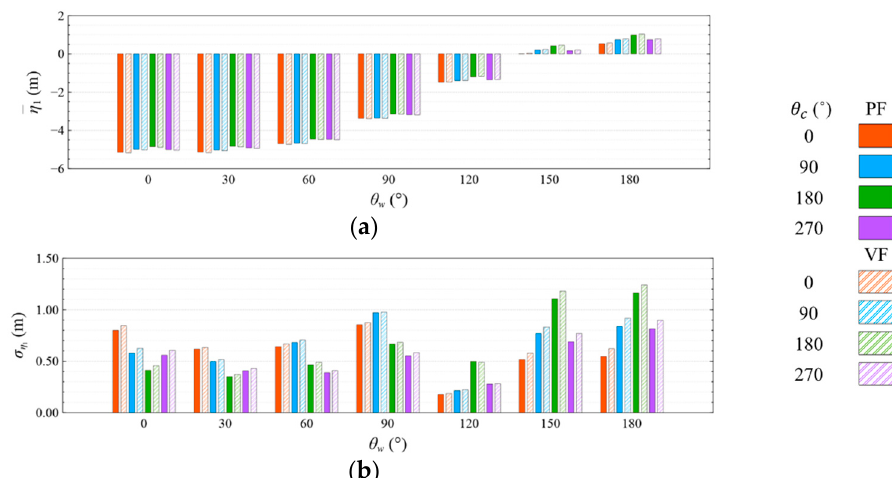
Figure 21. Comparison of ( a ) means and ( b ) standard deviations of platform surge motion under HW condition.